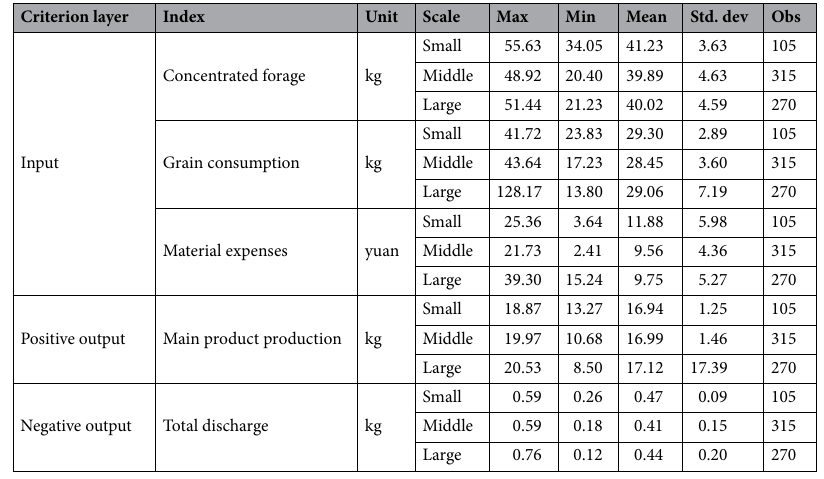
Table 1. Descriptive statistics of input and output indicators.